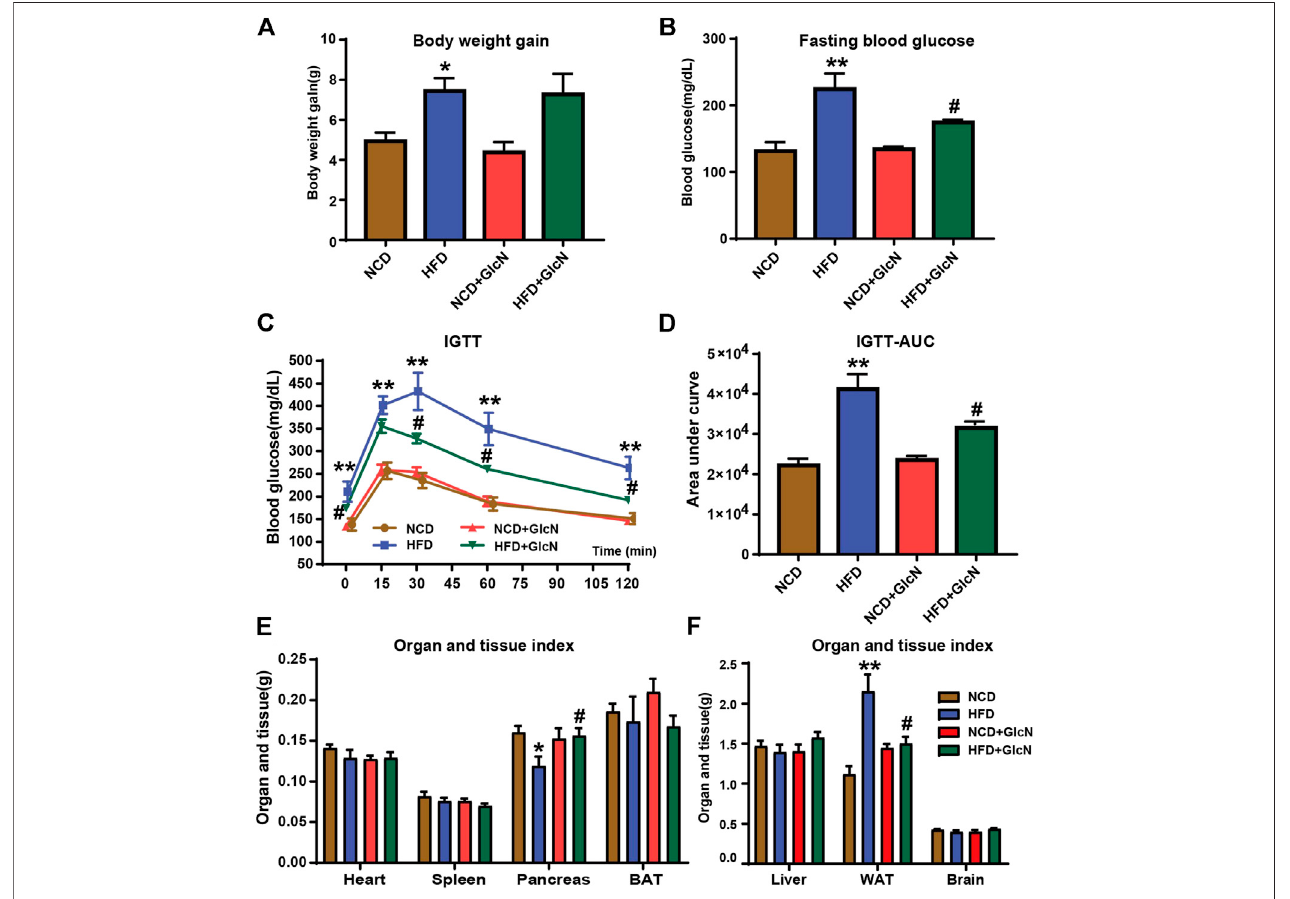
FIGURE1| EffectofGlcNonpathophysiologicsymptomsofdiabeticmiceinducedbyHFD-fed.AfterthemiceweretreatedwithNCD,HFD,and/orGlcN(1 mg/ml, in drinking water) for 5 months, the body weight (A) and fasting blood glucose (B) of mice were monitored. For the IGTT experiment, the blood glucose at different time points among experimental groups was tested (C) , and the area under the glucose tolerance curve was calculated (D) . Also, the visceral indices of major organs were detected, including heart, spleen, pancreas, BAT, liver, WAT, and brain (E,F) . Data were shown as means ± SEM ( n (cid:1) 5). * p < 0.05, ** p < 0.01 indicates the difference between HFD group and NCD group; # p < 0.05, ## p < 0.01 indicates the difference between HFD + GlcN group and HFD group.